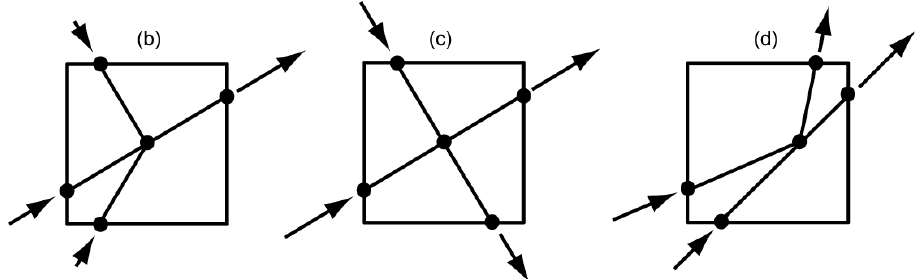
Figure 23. Schematic of three simple fracture networks (b,c,d), with the Darcy velocities corresponding to a flow experiment with a constant horizontal gradient. All the fractures have the same aperture. The lengths of the 4 fractures are identical in cases b and c, and the local conductivities are also identical. The letters (b,c,d) above the graphs correspond to the cases discussed in the text and to the results reported in Table 5.